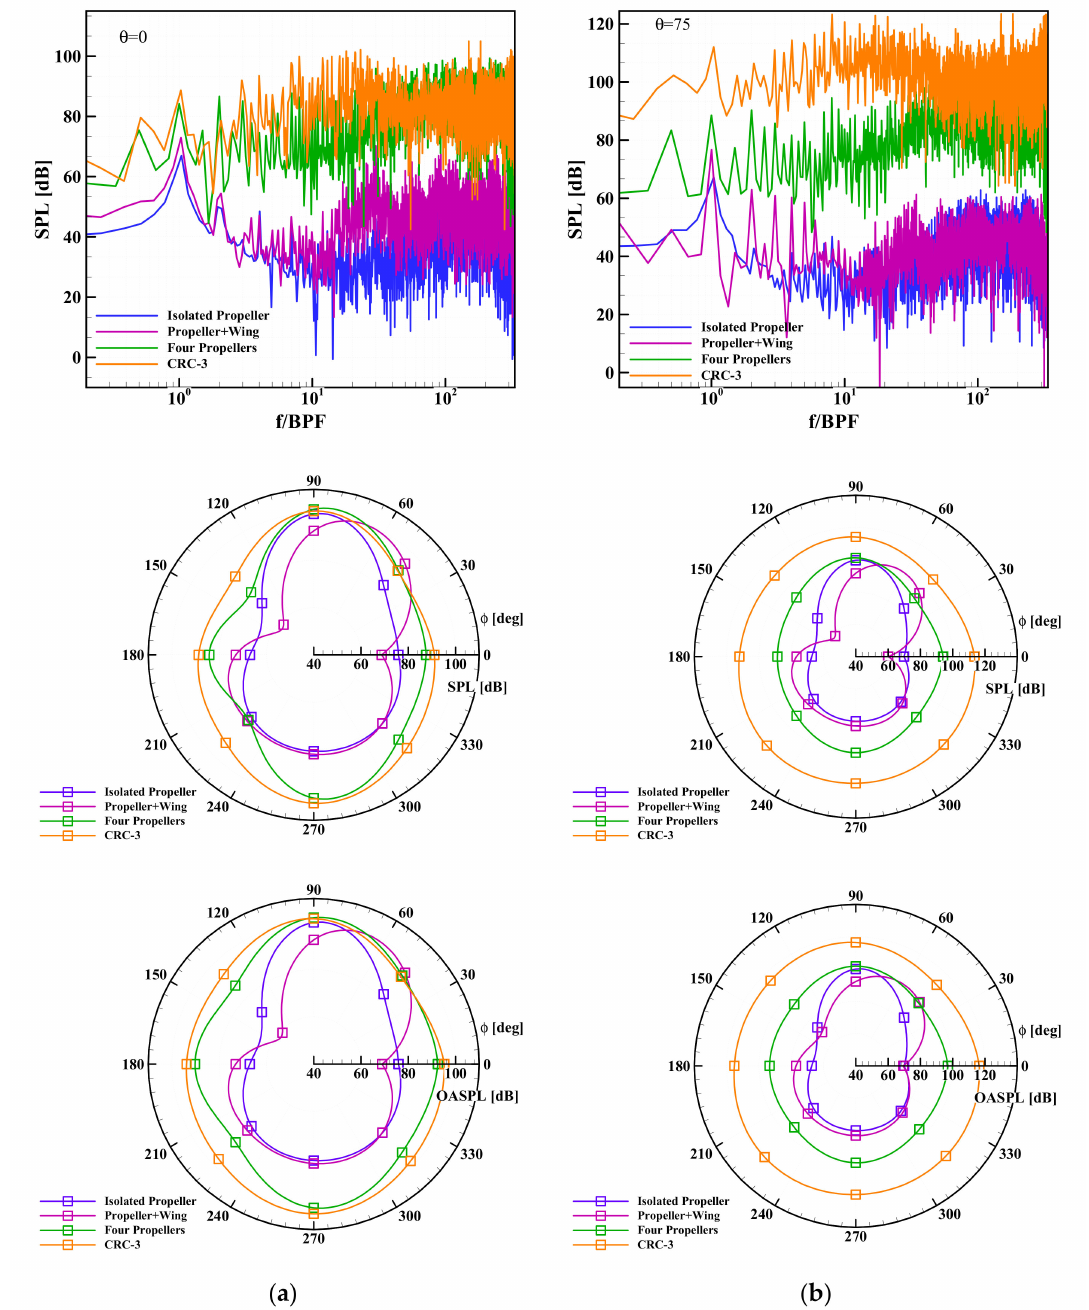
Figure 7. Variation of SPL spectra and directivity of SPL and OASPL versus pitch for various configurations: ( a ) θ = 0 ◦ ; ( b ) θ = 75 ◦